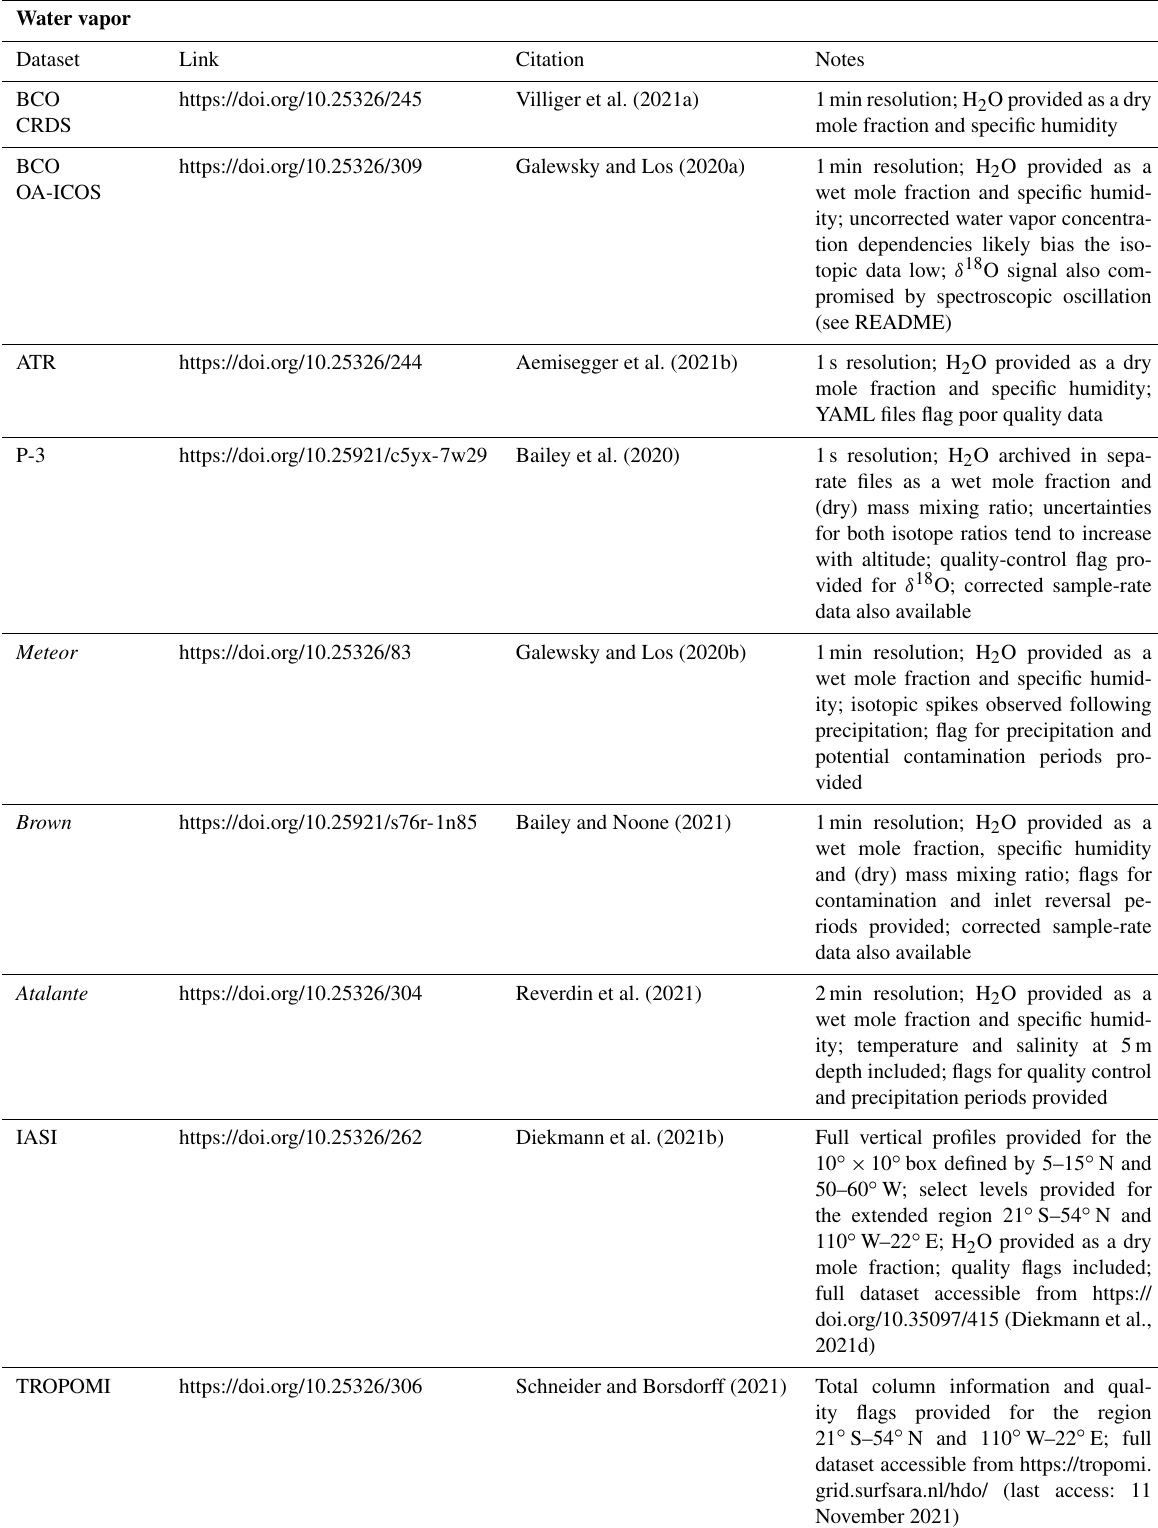
Table 3. EUREC 4 A-iso in situ and remotely sensed